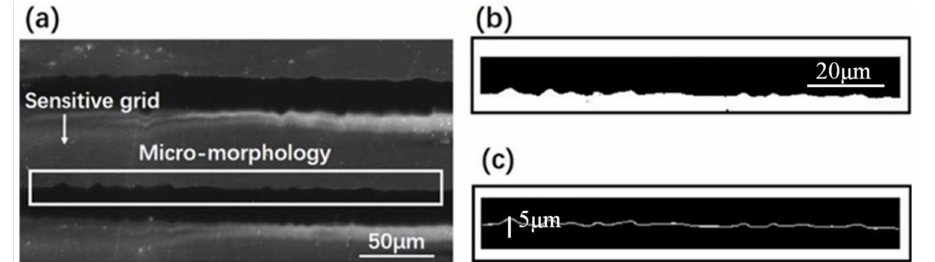
Figure 1. The microscopy image and the obtained sidewall micro-morphology of a typical strain gauge. ( a ) Scanning electron microscope image, ( b ) Binary image, and ( c ) Sidewall profile of a single sensitive grid.